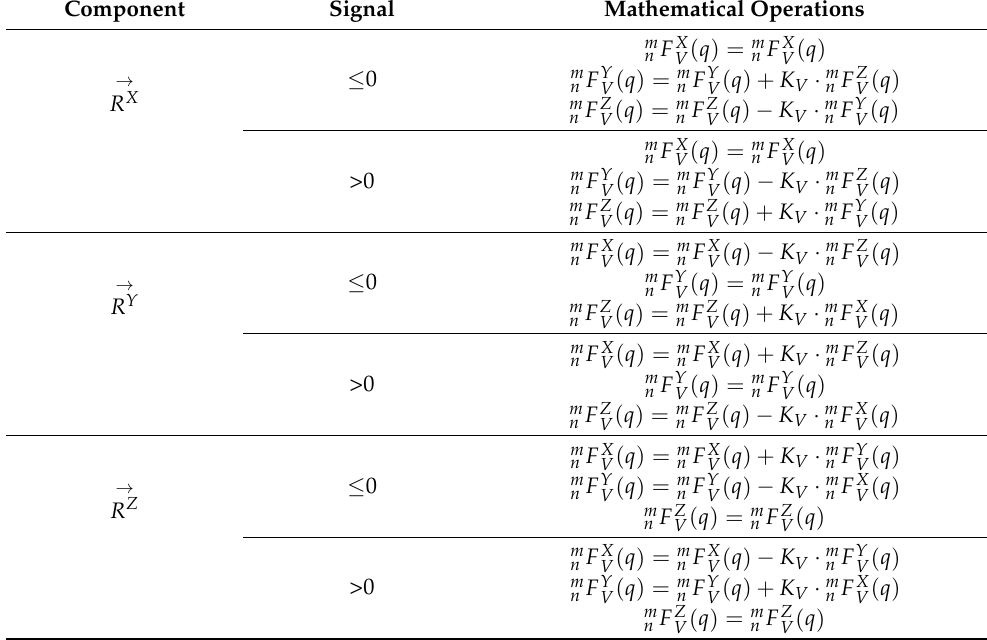
Table 2. Definition of the vortex